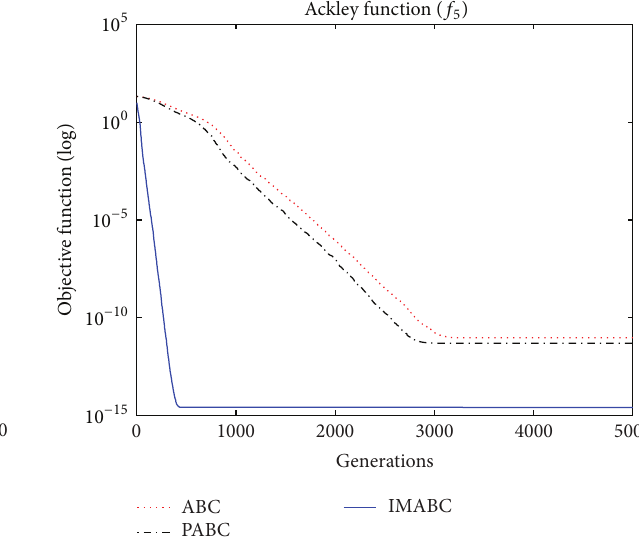
Figure 5: 𝑓 3 function convergence performance comparison.